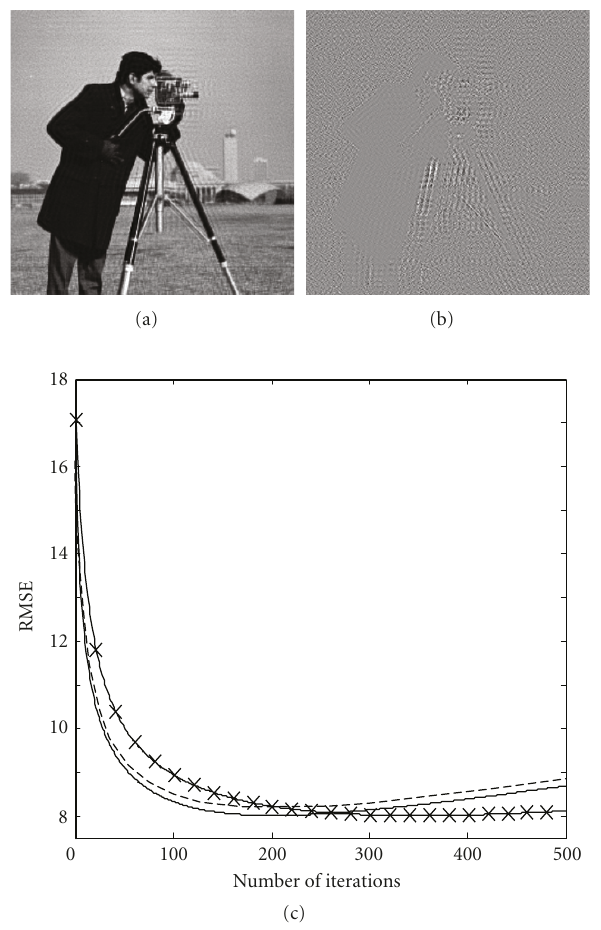
Figure 9: Result for Experiment 1 using (27): (a) restored image by simplified form (27) of AAMAPE (15) corresponding to maximum SNR (203 Iterations), (b) residual corresponding (a), and (c) RMSE of the MAPE (solid line with x ), AAMAPE (solid line), and AAMAPE simplified form given by (27) (dotted